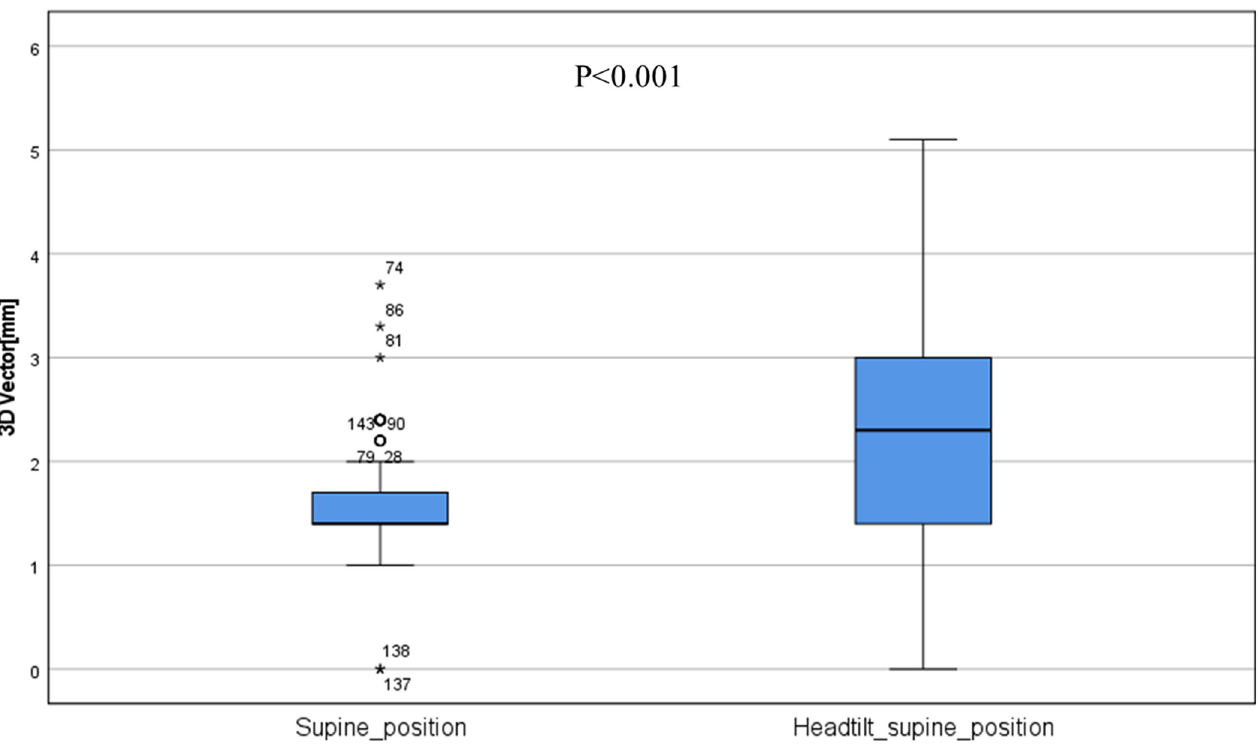
Fig 7. Boxplot and p -value of the Mann–Whitney U-test in the three-dimensional radiotherapy (3D) vector between the c-SP and ht-SPs.